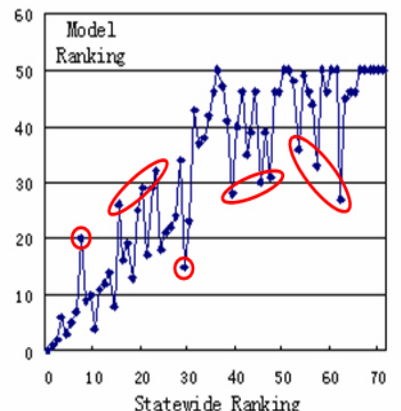
Fig.6. Model Evaluation for Type-422 Intersection